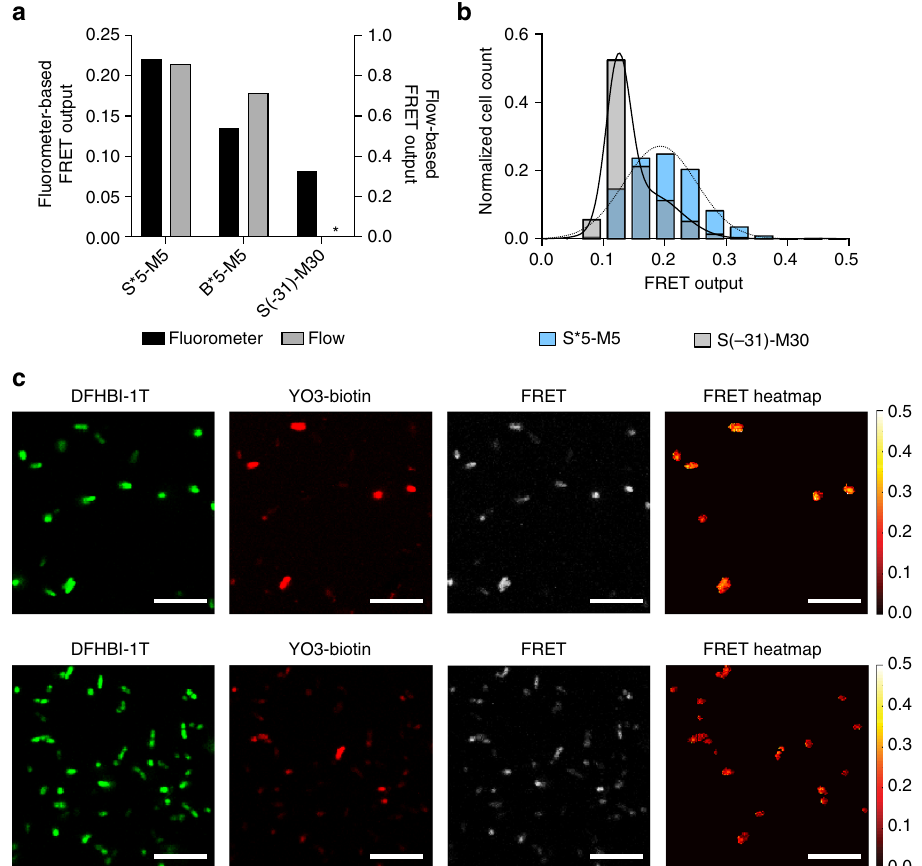
Fig. 4 Studies of apta-FRET constructs expressed in E. coli . a FRET outputs of S*5-M5, B*5-M5, S(-31)-M30, and 2H-AE constructs. Black bars are FRET outputs calculated based on spectro fl uorometric measurements, gray bars are calculated based on fl ow cytometry measurements. The asterisk denotes a FRET output that is effectively zero (see Supplementary Table 3). b Single cell analysis of confocal microscopy images of the S*5-M5 (blue) and S(-31)- M30 (gray) constructs. The analysis is based on 10 images of each construct. The solid line is a sum of two Gaussians fi tted to the S(-31)-M30 FRET outputs; the dotted line is a single Gaussian fi tted to the S*5-M5 FRET outputs. c Confocal microscopy and FRET heatmap images of cells expressing the S*5-M5 (top) and S(-31)-M30 (bottom). In the FRET heatmap images to the right, red colors indicate low FRET outputs and yellow colors indicate high FRET outputs. Only bacteria displaying fl uorescence from both DFHBI-1T and YO3-biotin were selected for representation in the heatmap (see Methods section and Supplementary Fig. 10 for further details on the selection process). The scale bars correspond to 10 µ